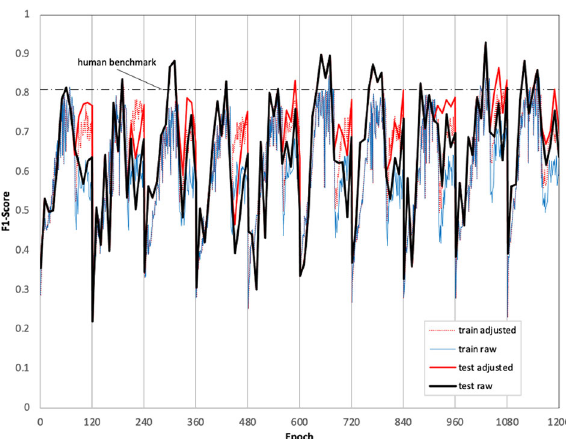
Fig. 3 Monte-Carlo dropout model F1-scores during training. F1-Scores evaluated on the training and test sets during tenfold cross-validation